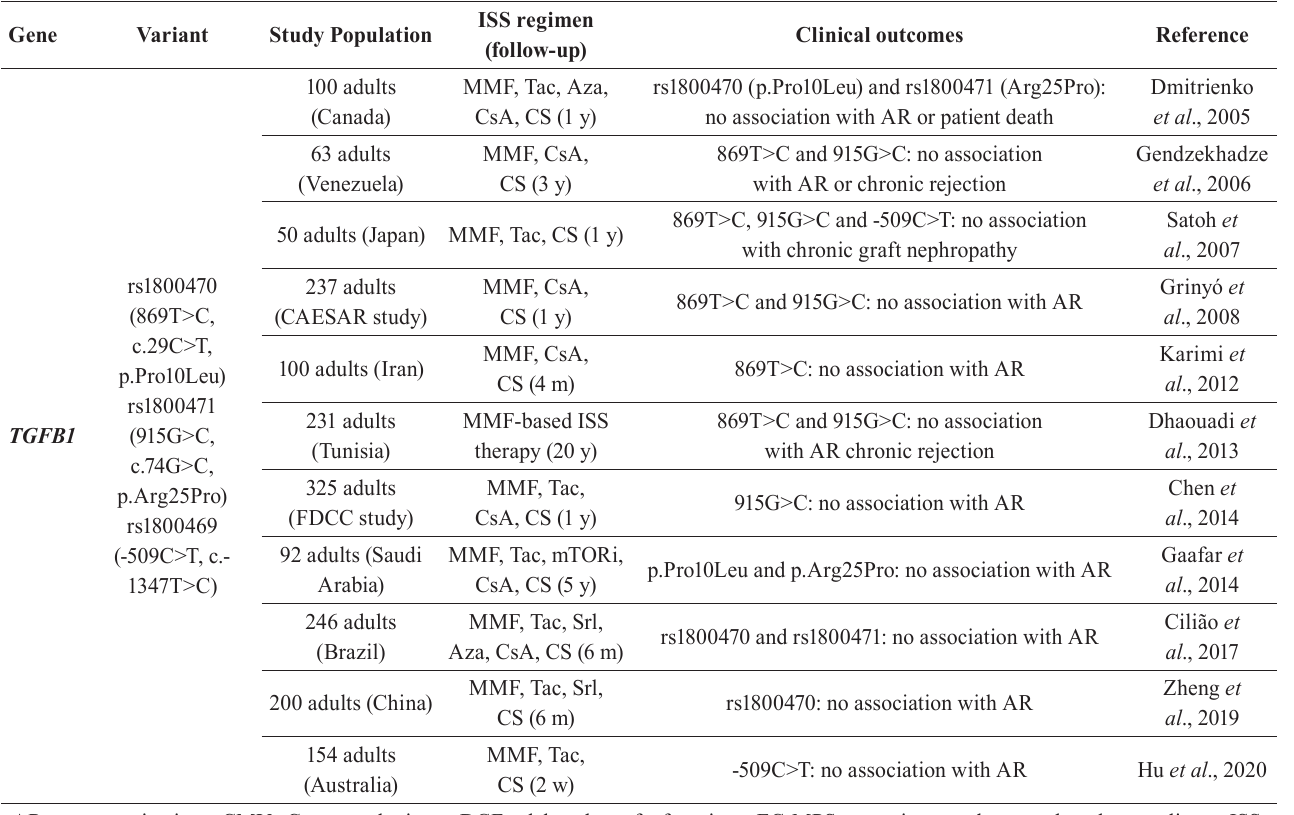
TABLE V - G enes relat ed to immunomodulatory cytokines in kidney recipients on MPA therapy without significant associations Gene